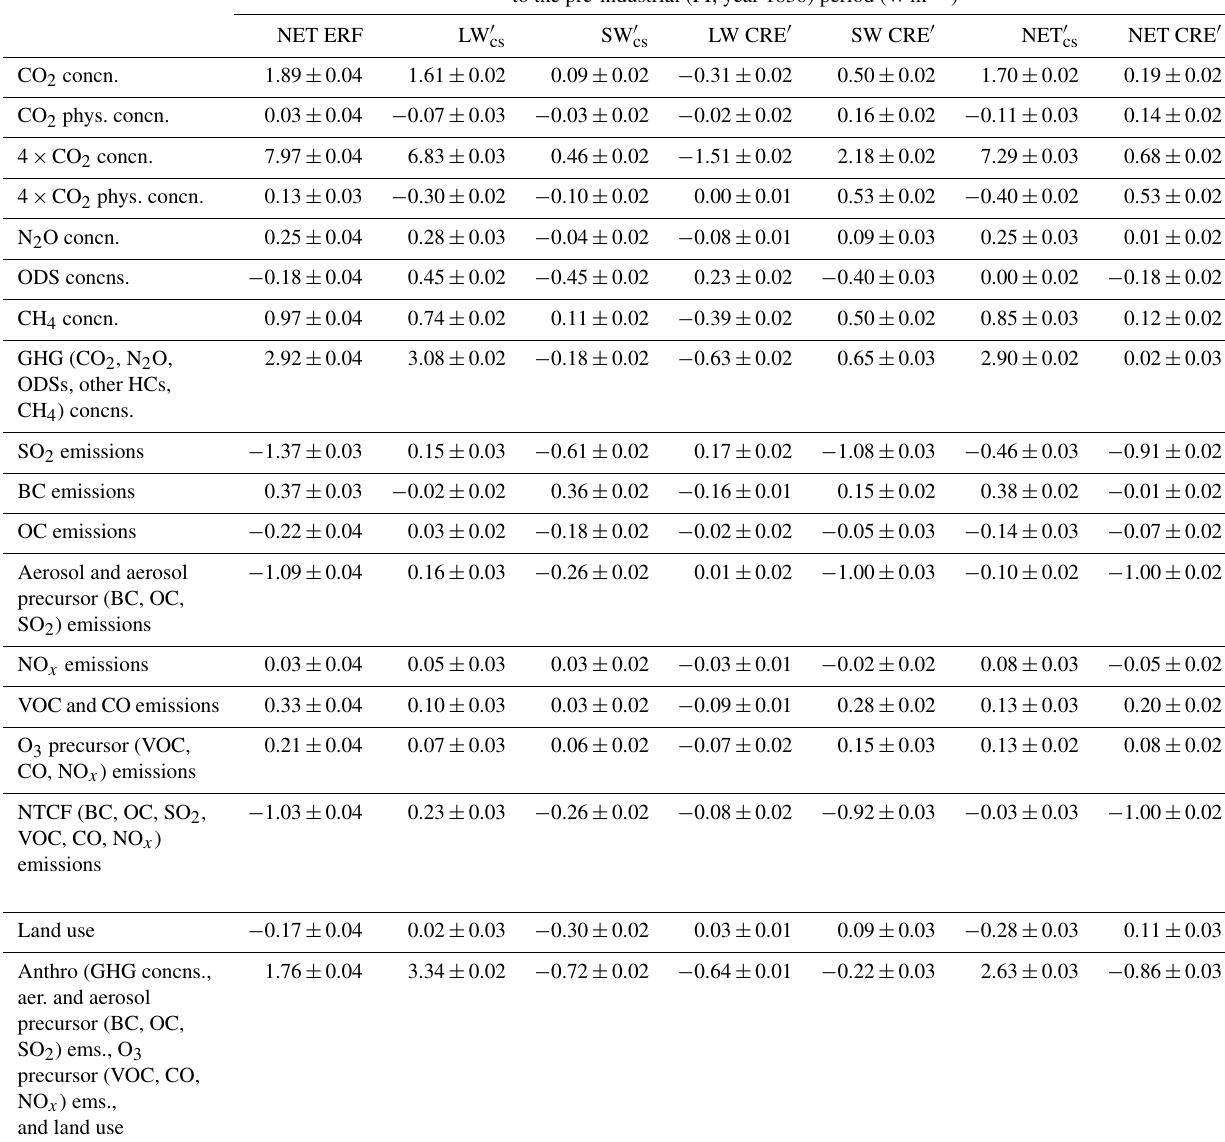
Table 3. Present-day (year 2014) ERFs relative to the pre-industrial (year 1850) period derived from Eq. (8) and including an estimate of the standard error. Where duplicate experiments exist (e.g. piClim-SO2 ; Table 2), the quoted ERFs are based on Realization IDs R2. Units in Wm − 2